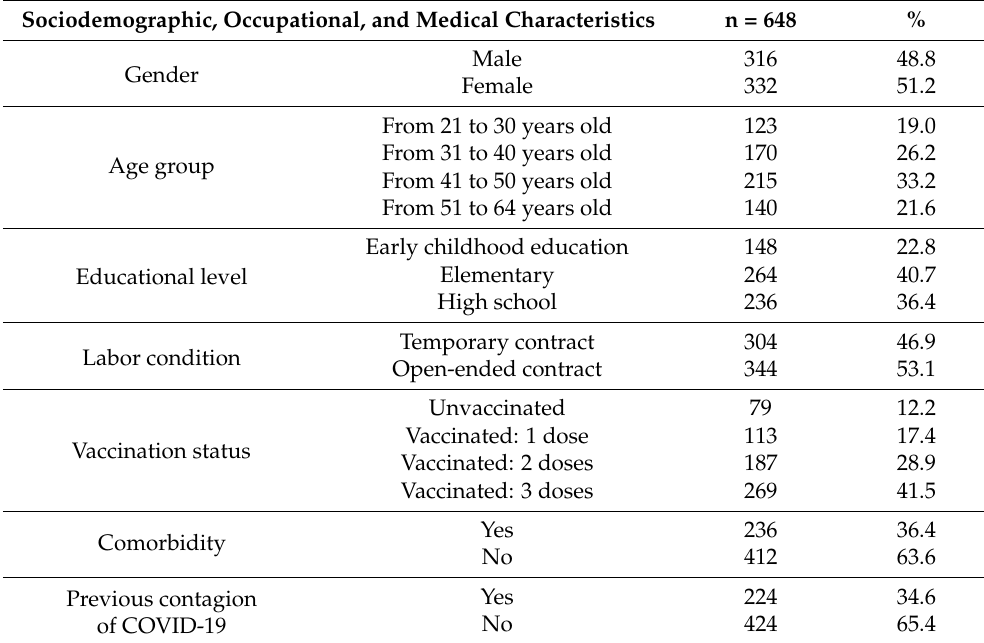
Table 1. Sociodemographic, occupational, and medical characteristics of the sample. Sociodemographic, Occupational, and Medical